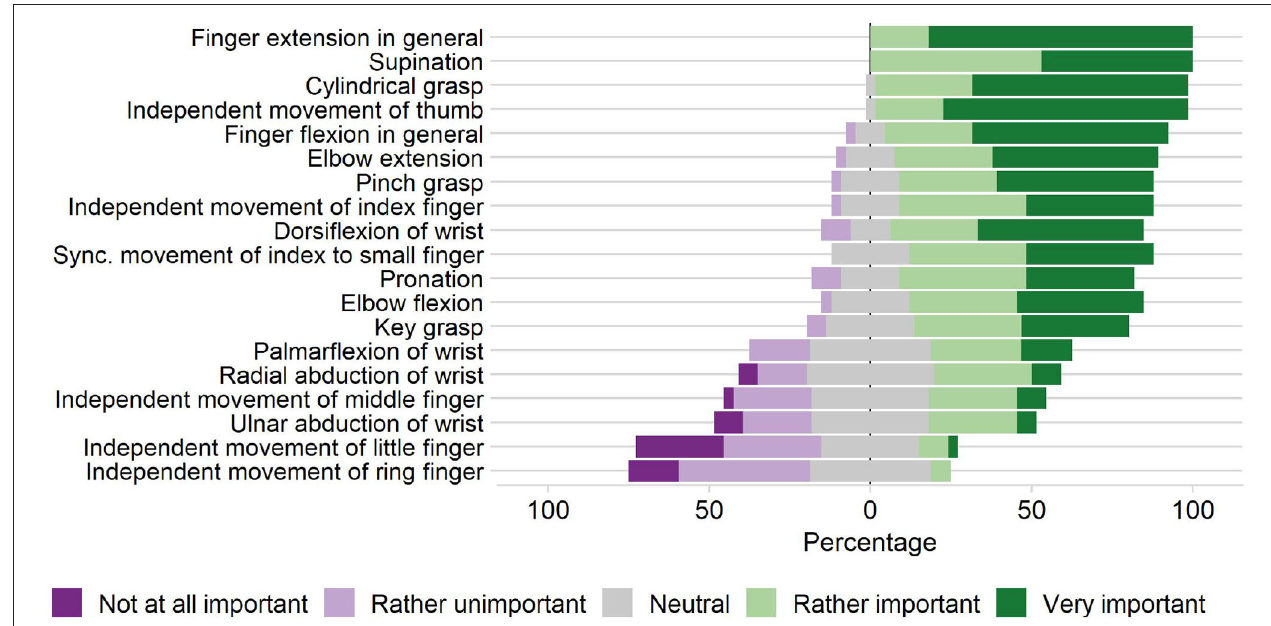
FIGURE 2 | Clinical requirements. Importance of practicing various upper-limb movements in stroke rehabilitation according to our survey with 33 participants (therapists, nurses, and physicians working in neurorehabilitation) from the University Hospital Bern, Switzerland and Reha Rheinfelden, Switzerland.